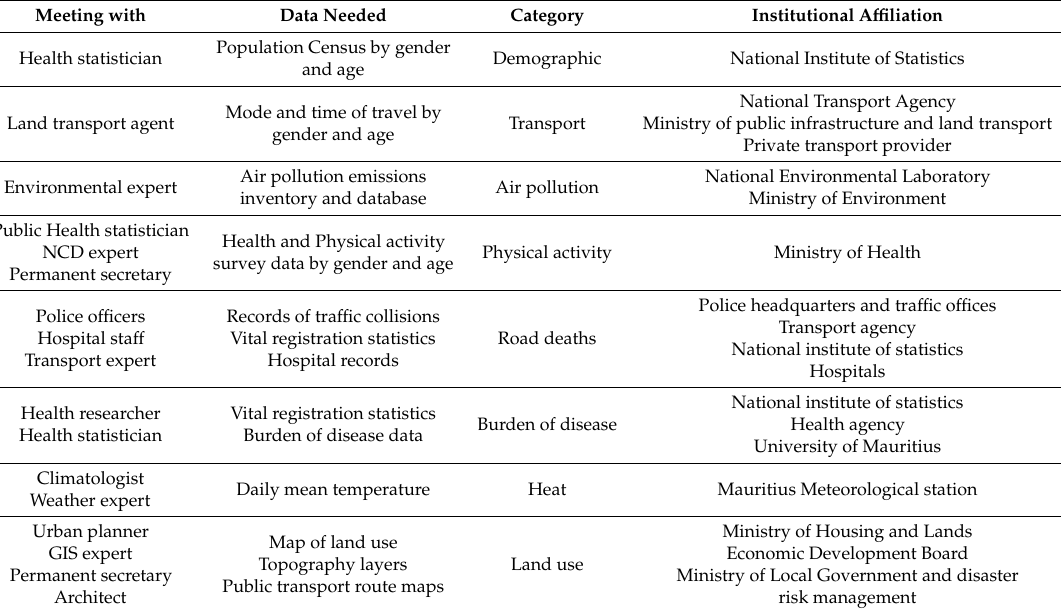
Table 2. Non-recorded meetings for secondary data.